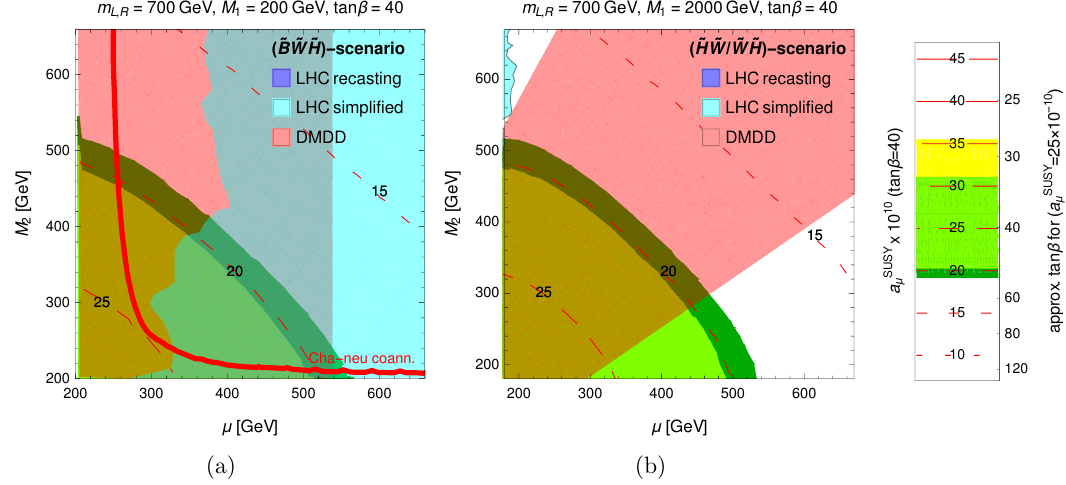
(b) ˜ ˜ ˜ ˜ ˜ ˜ ˜ Figure 18. (a) ( B W H ) -scenario. (b) ( H W/ W H ) -scenario. For parameter values see the plots and the text. The red dashed contours correspond to values of a SUSY as indicated in the legend µ on the right; the yellow/green coloured regions correspond to the 1 σ bands corresponding to the BNL deviation (1.6) and the new deviation including FNAL (1.7), and their overlap. For the tan β - reinterpretation see caption of figure 15. The red shaded region is excluded by dark matter direct detection if the LSP is assumed stable; in the left plot this red region is the rectangle extending up to µ ≈ 540 GeV. Both plots do not contain regions excluded by the LHC recasting. The cyan shaded regions correspond to the additional LHC limits implemented in a simplified way. In the left plot the cyan region is the large region extending from µ & 300 . . . 400 GeV to the right (it is partially overlaid with dark matter and a SUSY -regions), it mainly arises from the stau-channel chargino µ search (6.10), ref. [524]; it is valid if light staus are assumed for stau-coannihilation. The red thick line in the left plot corresponds to the parameter strip where chargino-neutralino coannihilation is possible; in this region the dark matter relic density can be correctly described without light staus and the LHC-constraint does not